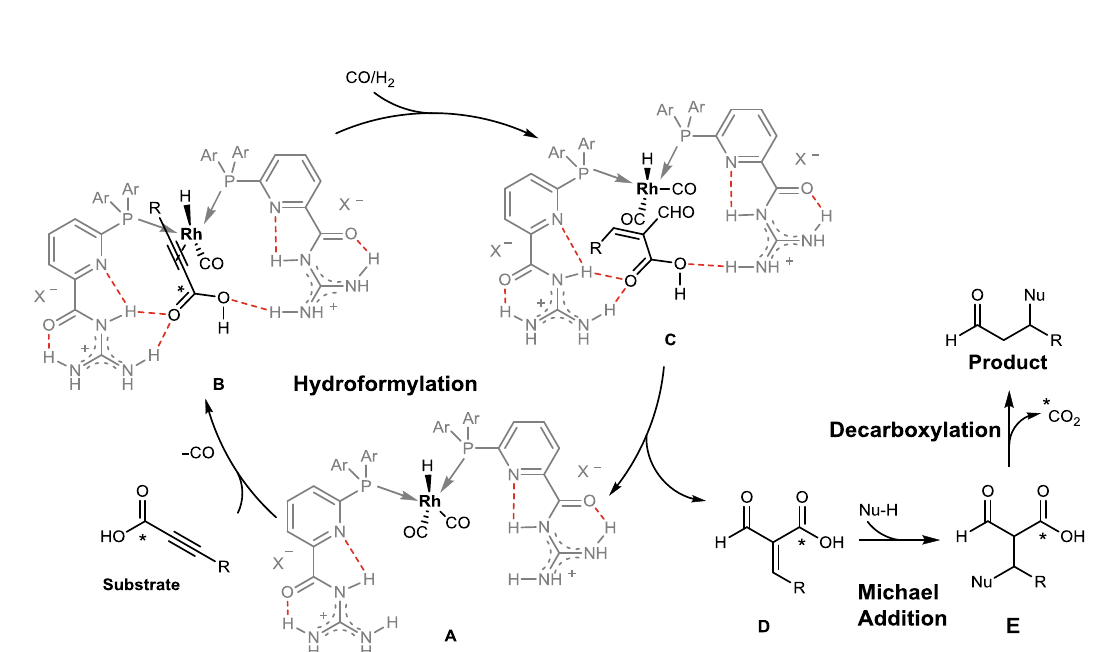
Fig. 3 Proposed reaction mechanism. It includes Rh-catalyzed hydroformylation of α -alkynoic acids, Michael addition of arene nucleophiles, and